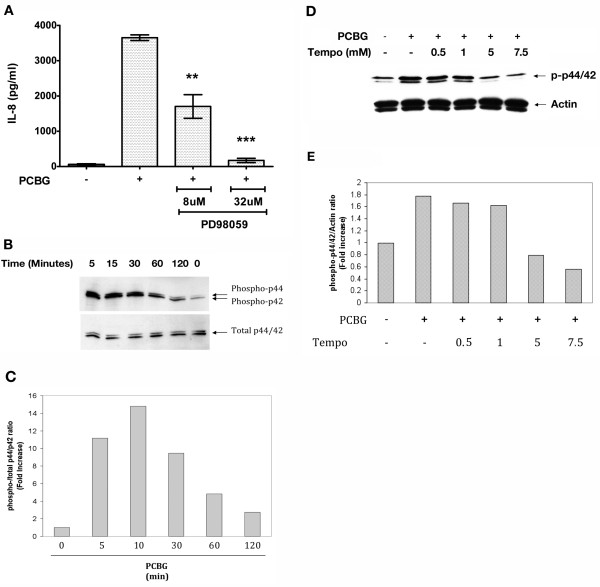
PCBG induces activation of ERK in 1HAEo- airway epithelial cells. A. 1HAEo- cells were challenged with 100 ug/ml of PCBG for eight hours and IL-8 release assessed by ELISA in the culture supernatants. Cells were pretreated for 1 hour with the ERK inhibitor PD 98059 or vehicle solution as indicated prior to the addition of PCBG. Data were analyzed with one-way ANOVA and posttest Bonferroni comparison (**denotes p < 0.01; ***denotes p < 0.001). B. 1HAEo- cells were incubated with 100 ug/ml of PCBG for the indicated times, and phospho-p44/p42 and total p44/p42 were detected by western blot in the total cell lysate. C. Densitometry analysis of phospho- p44/p42 to total-p44/p42 ratio. D. 1HAEo- cells were pre-incubated for 1 hour with different concentrations of TEMPO prior to stimulation with 100 ug/ml of PCBG for 10 minutes, phospho-ERK p44/p42 was detected by Western blot in the total cell lysate. Actin was shown as loading control. E. Densitometry analysis of phospho- p44/p42/Actin ratio. The data shown is representative of at least two independent experiments.